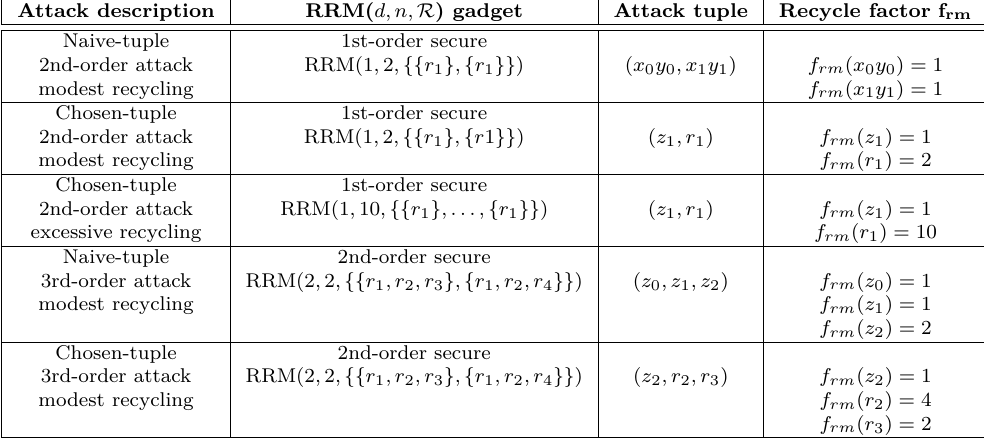
Table 3: t − NI RRM gadgets analyzed in the noisy leakage model assuming naive-tuple (C1) and chosen-tuple (C2) adversaries. The attacks exploit a large amount of the available recycling (case C2, excessive recycling) or a small amount of recycling (case C2, modest recycling) or they disregard recycling (case C1).